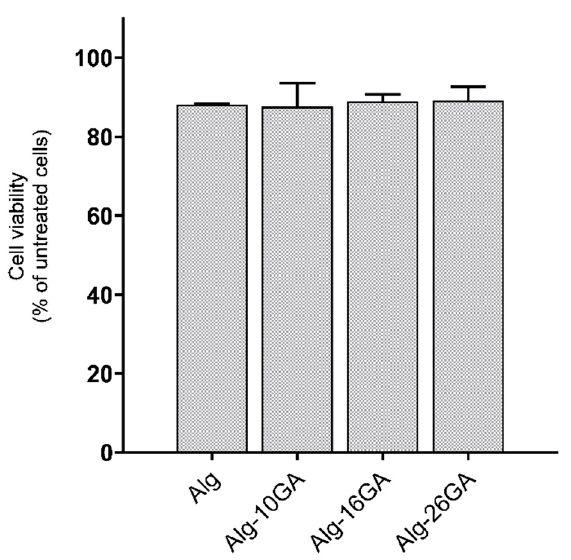
Figure 9. Viability of BJ cells after 24 h in the presence of Alg-xGA (x = 0, 10, 16, and 26 wt.%) composites.